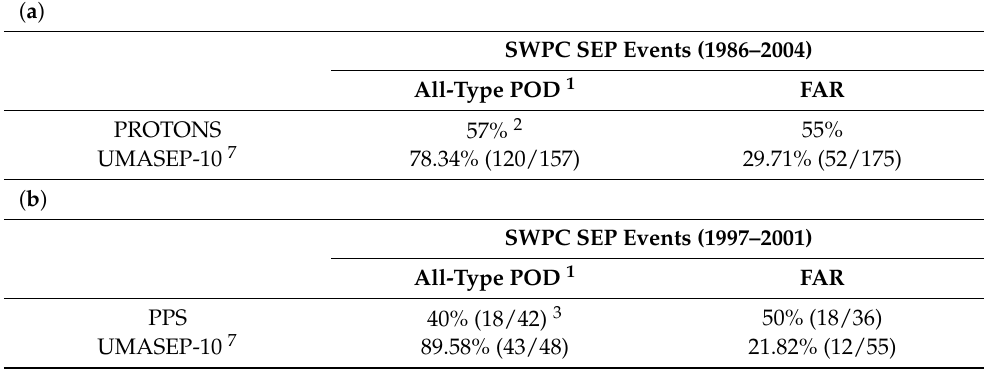
Table 3. Comparison of UMASEP-10 version 2.2 (the most recent version of this tool) with: ( a )